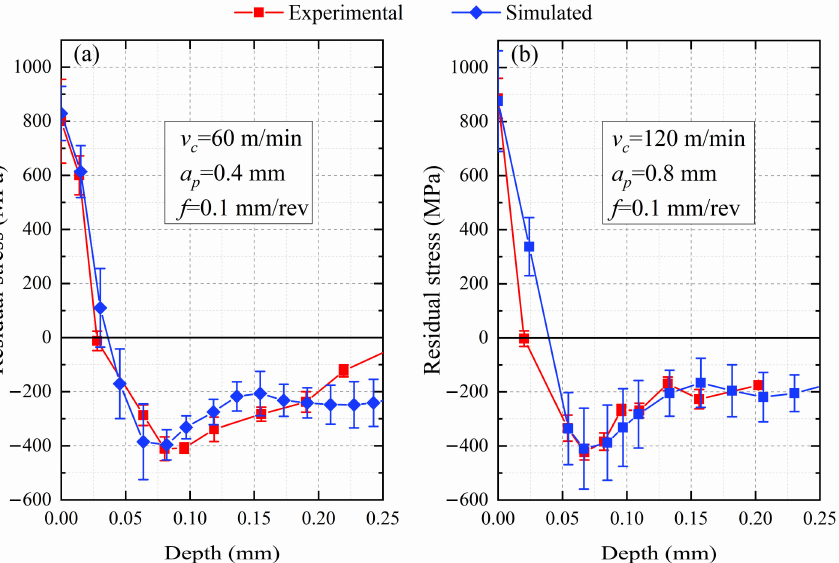
Figure 4. The comparison of the residual stresses in the experiments and simulations, where f equals 0.1 mm/rev. ( a ) v c and a p equal 60 m/min and 0.4 mm, respectively. ( b ) v c and a p equal 120 m/min and 0.8 mm, respectively